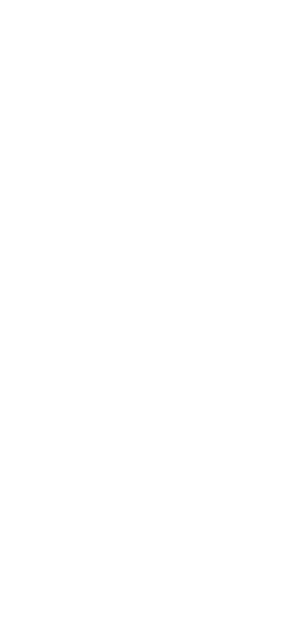
Table 2. Complete amino acid analysis of PPI, SPI and EverPro, comprising of total amino acids quantification on a dry matter basis, free amino acid quantification on a dry matter basis, and the determination of the % of the daily requirement of each essential amino acid per g of protein as outlined by the WHO